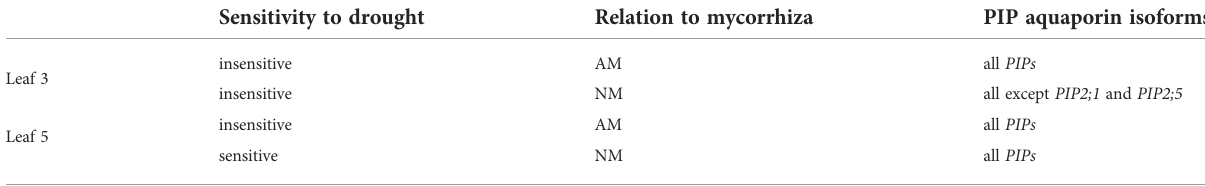
TABLE 1 Sensitivity of PIP aquaporin expression to drought in upper leaf (L3) and ear leaf (L5) in relation to plant symbiotic status. Sensitivity to drought Relation to mycorrhiza PIP aquaporin isoforms